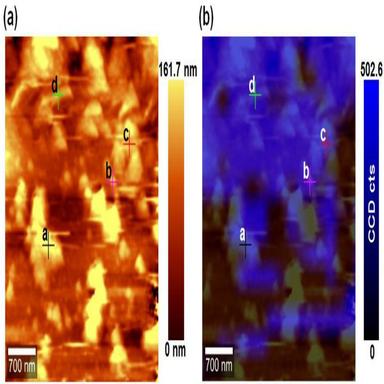
(a) AFM contact mode image of Ppy-GAC nanocomposite, and (b) the same image with an overlay of Ppy nanoparticles component Raman image (blue) of the Ppy-GAC nanocomposite sample.